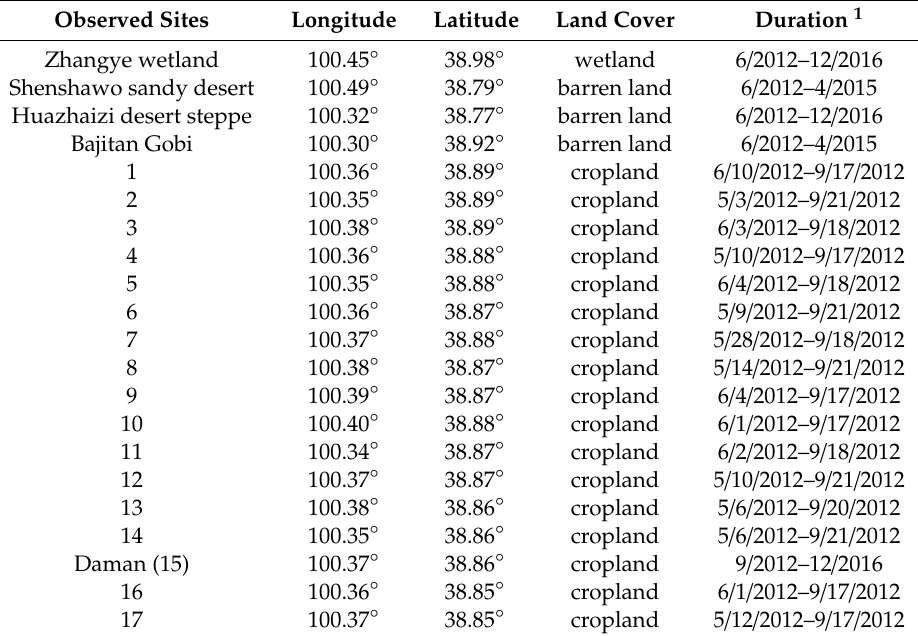
Table 1. Summary of EC Sites in the midstream of the Heihe River Basin